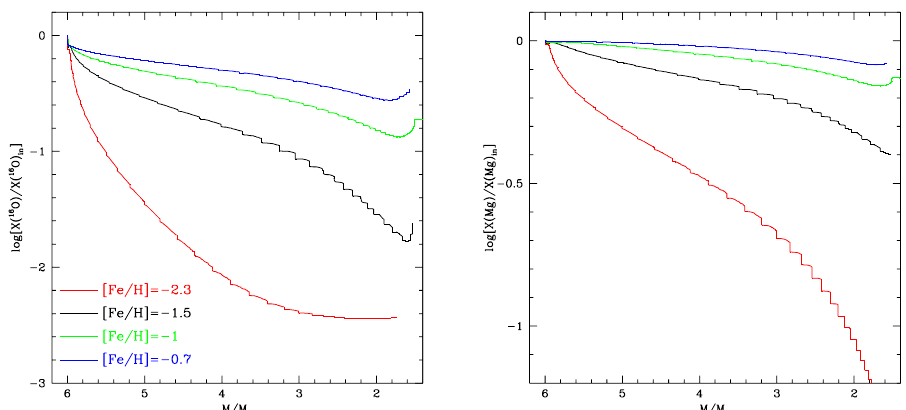
Figure 4. Variation of the surface mass fraction of 16 O ( left panel ) and magnesium ( right ) as a function of the current mass of model stars of initial mass 6 M (cid:12) and different metallicities. The mass fractions reported on the y -axis are in a logarythmic scale, and divided by the initial